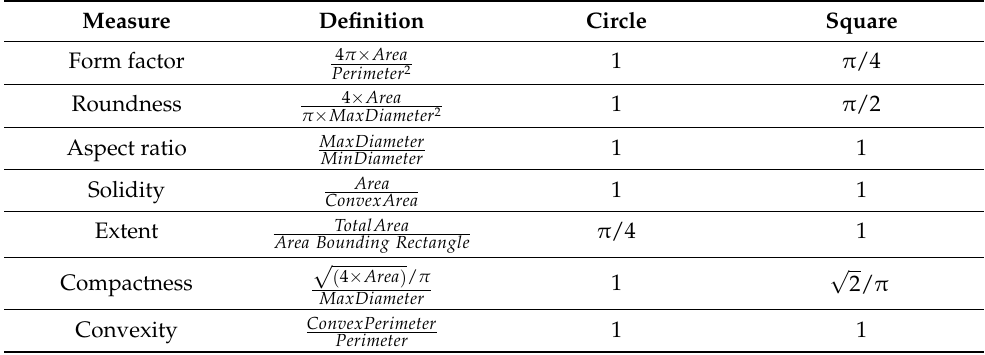
Table 1. Structural descriptors.